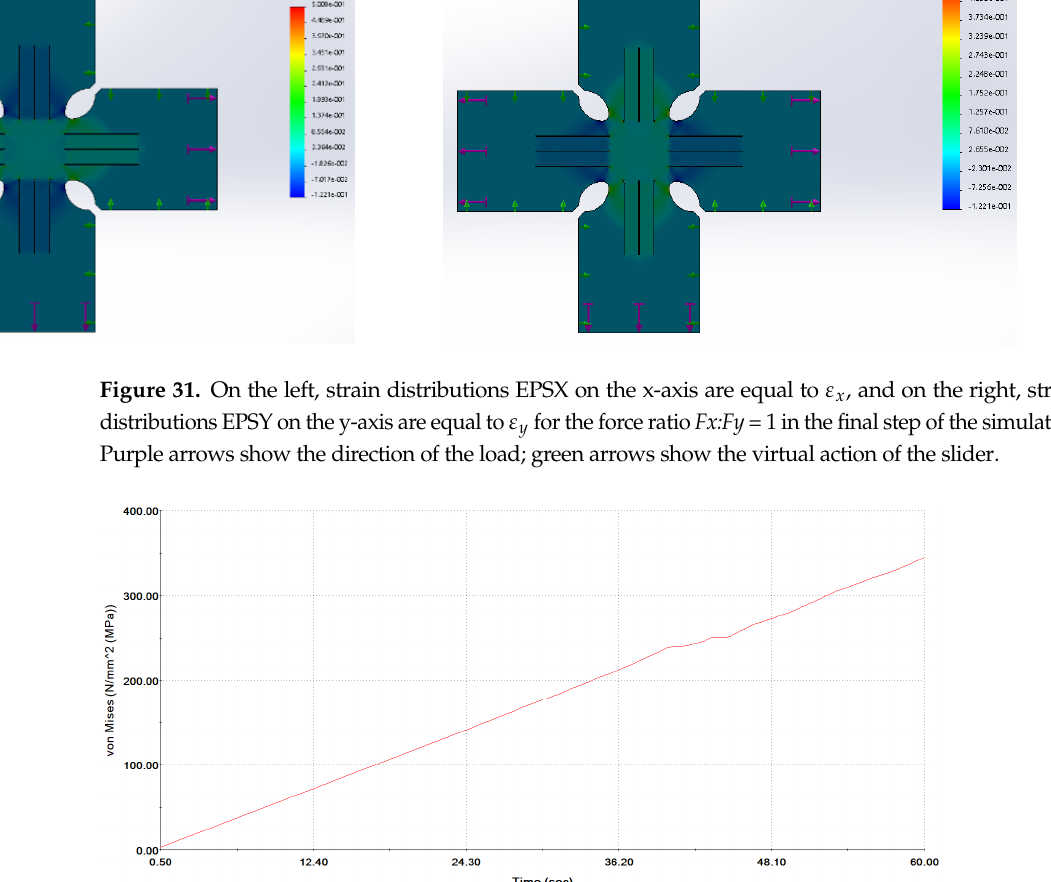
Figure 32. Graph of the change in the stress in the node number 34331, reflecting the center of the cruciform specimen during the time in the simulation .